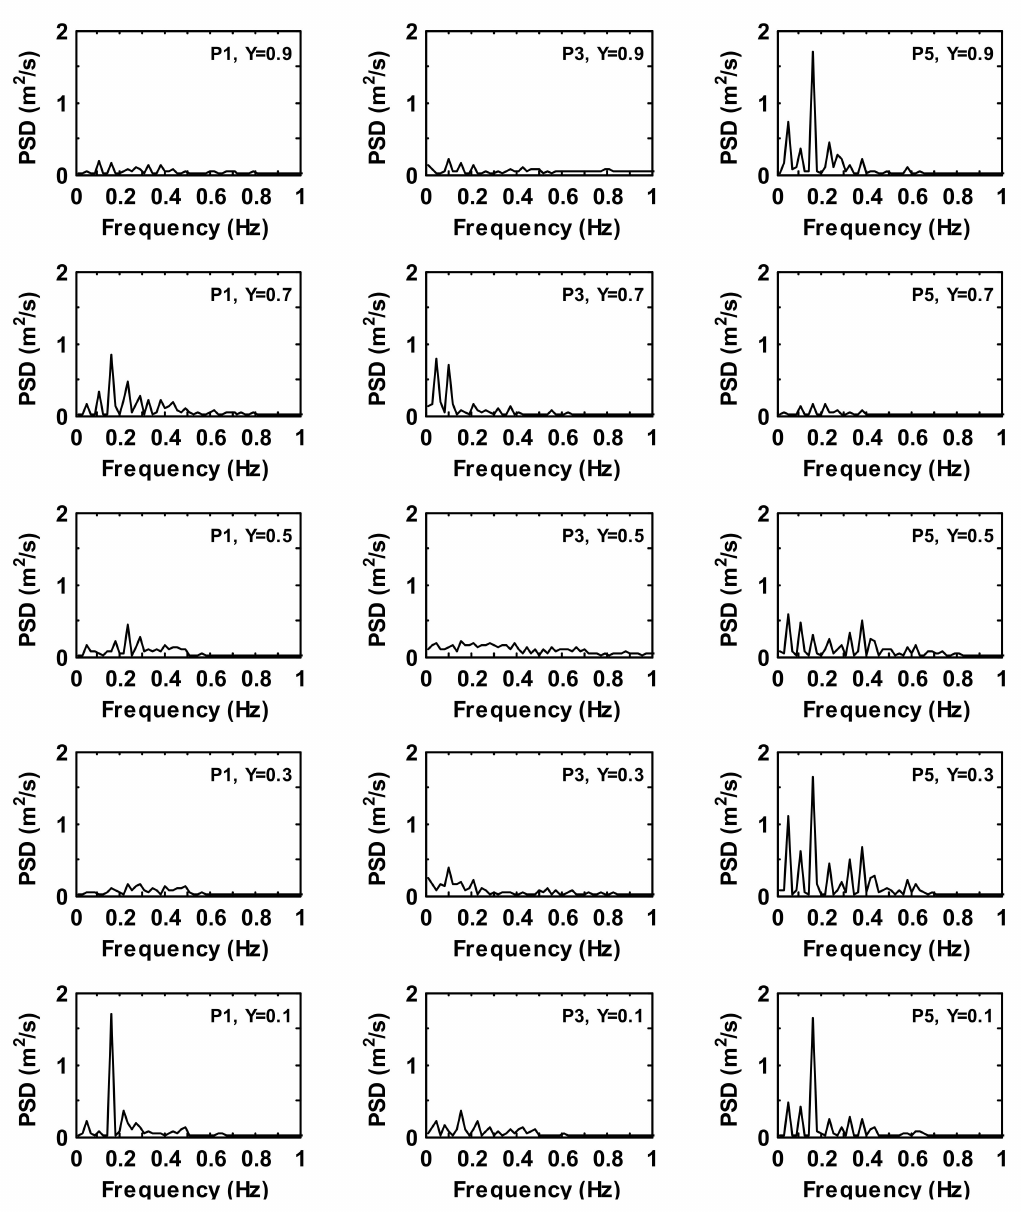
Figure 8. Power spectra density of the time history of velocity magnitude at prescribed monitoring locations P 1, P 3, P 5 for case